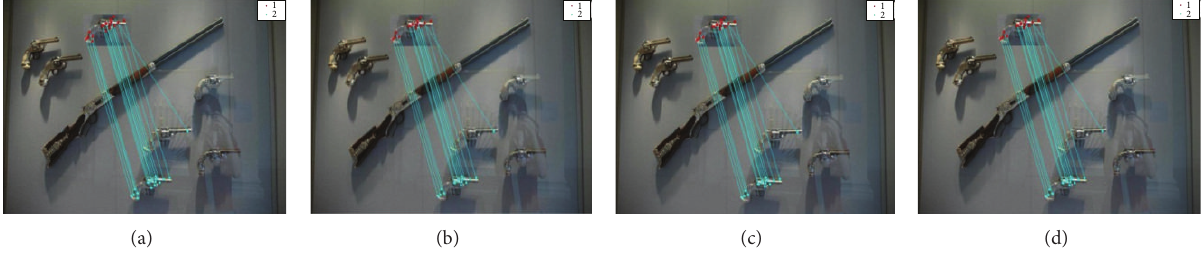
Figure 6: Copy paste detection results for noise addition: (a) SNR value 20, (b) SNR value 30, (c) SNR value 40, and (d) SNR value 50.